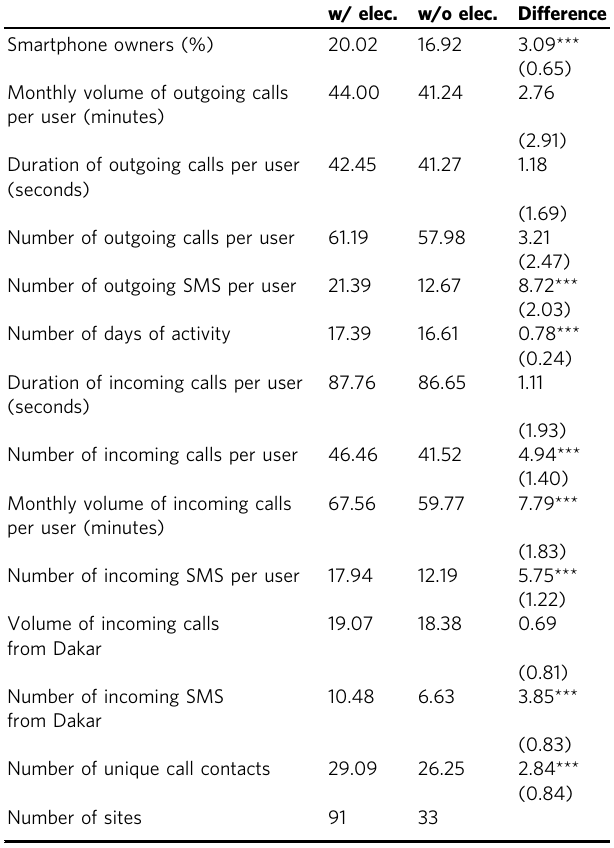
Table 3 Main results-propensity score matching estimates. w/ elec. w/o elec.